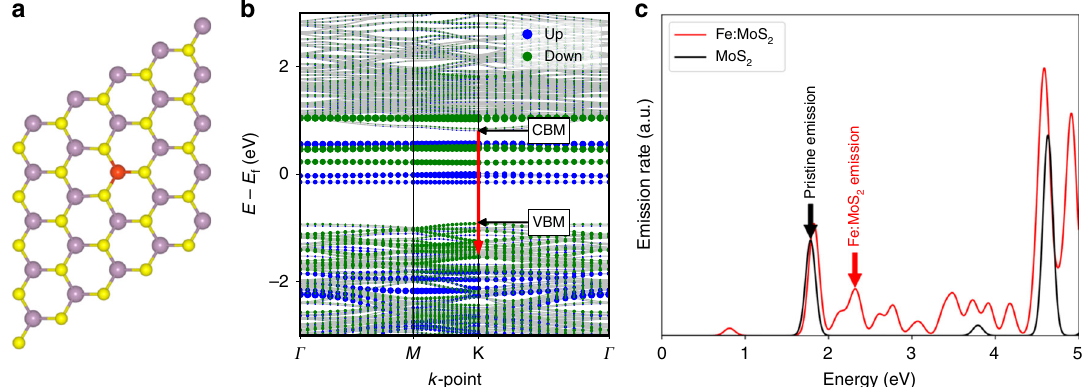
Fig. 3 DFT calculations of dipole-allowed transitions in Fe:MoS 2 monolayers. a 5 × 5 MoS 2 supercell with a single Fe dopant used to simulate Fe:MoS 2 , where Mo, S, and Fe atoms are shown as purple, yellow, and red spheres, respectively. b Spin-polarized band structure of Fe:MoS 2 . Spin-up (down) states are shown in blue (green). The area of each circle is proportional to the projection of the state onto the Fe atom. The red arrow shows the transition corresponding to the peak labeled “ Fe:MoS 2 emission ” in c . The CBM and VBM of the host MoS 2 are also labelled. c Spontaneous emission rates of excited MoS 2 and Fe:MoS 2 . The emission of both MoS 2 and Fe:MoS 2 was taken from the spin-up CBM states in their respective systems. For Fe:MoS 2 , this state is indicated by the tail of the red arrow in b DFT modeling of Fe-related emission . To investigate the centered on the Fe atom. The plot indicates that the presence of microscopic origin of the Fe-related PL peak at 2.28 eV, we used Fe introduces states that lie inside of MoS 2 ’ s pristine bandgap. In DFT to calculate the electronic structure of Fe:MoS 2 (see Methods addition, the fact that the large blue and green circles inside the section). An isolated Fe dopant was simulated by replacing a gap do not overlap indicates that the Fe induces a magnetic single Mo atom with Fe in a 5 × 5 MoS 2 supercell, as shown in moment. Figure 3c plots the spontaneous emission (SE) rates Fig. 3a. Figure 3b plots the spin-polarized band structure for this from the spin-up conduction band minimum (CBM) state and system, where the area of each blue (green) circle is proportional compares them with those from the CBM in pristine MoS 2 . We see that the smallest emission energy for the pristine MoS 2 state is to a spin-up (down) state ’ s overlap with a sphere of radius 1.3 Å